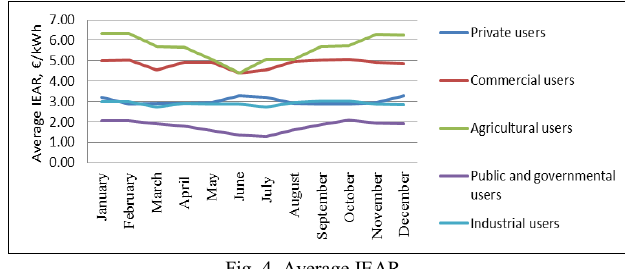
Fig. 4. Average IEAR.